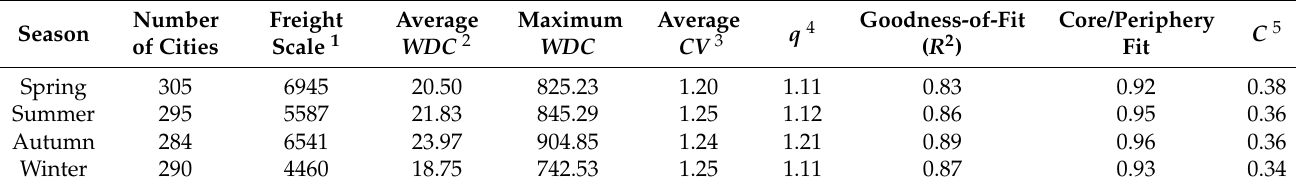
Table 2. Statistical characteristics of agricultural product circulation networks in